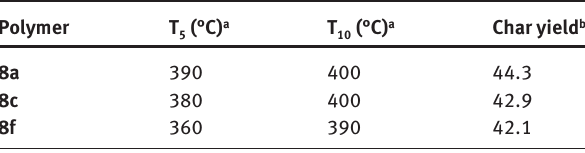
Table 4: Thermal behavior of PAIs 8a , 8c and 8f